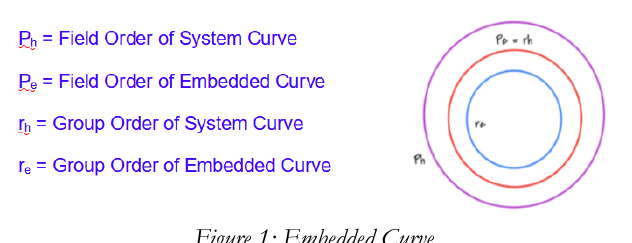
Figure 1: Embedded Curve